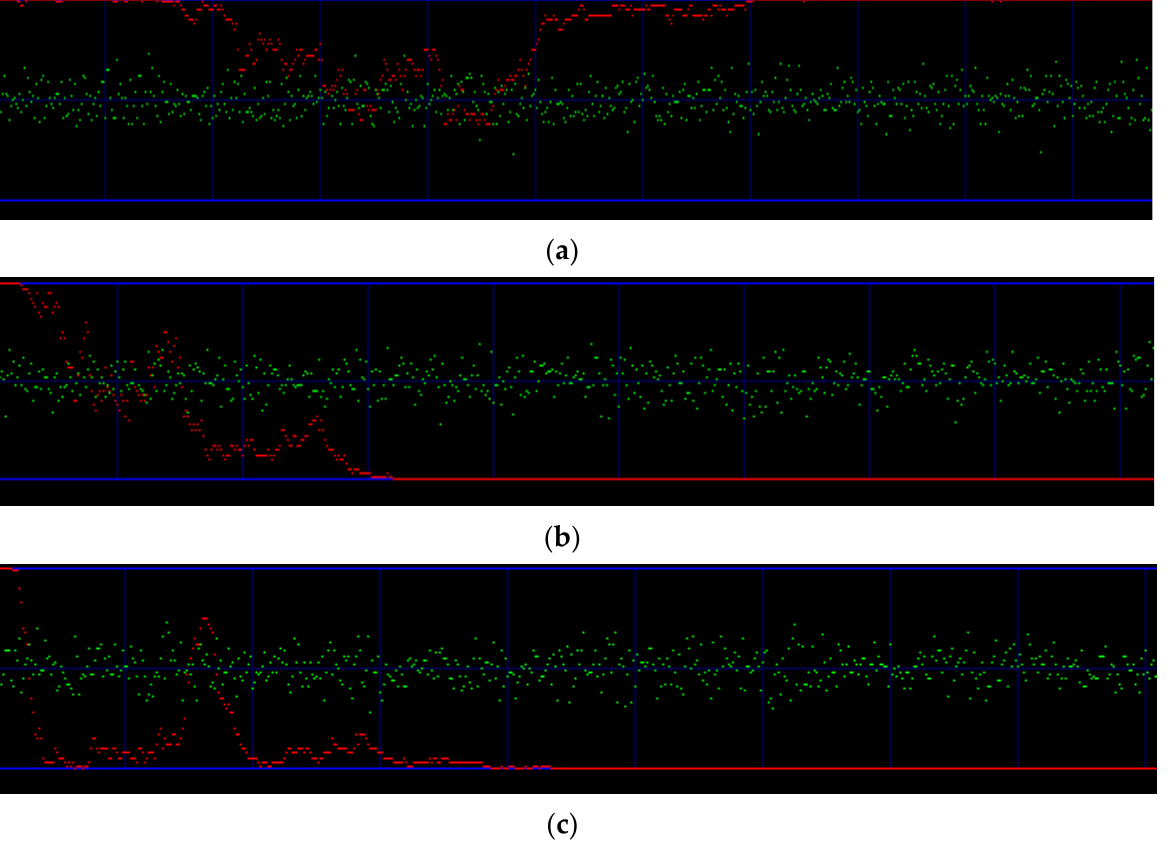
Figure 7. Chi-square attack for 1 bit-LSB and the proposed method using Zelda stego images. ( a ) 1-bit LSB Zelda. ( b ) Proposed Zelda stego 1. ( c ) Proposed Zelda stego 2.